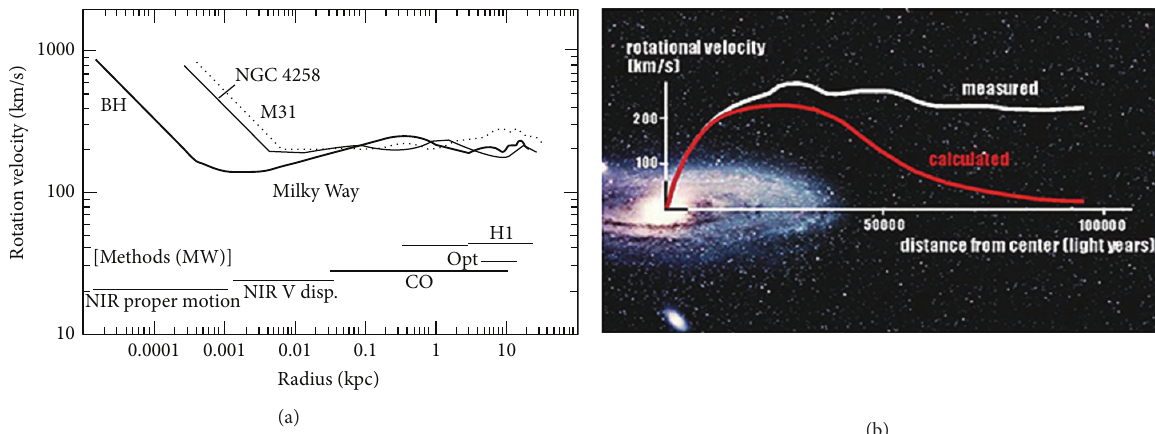
Figure 4: (a) shows the rotational velocity of stars as a function of distance from the center for three galaxies, the Milky Way, M31, and NGC 4258. (b) is a pictorial representation [20,